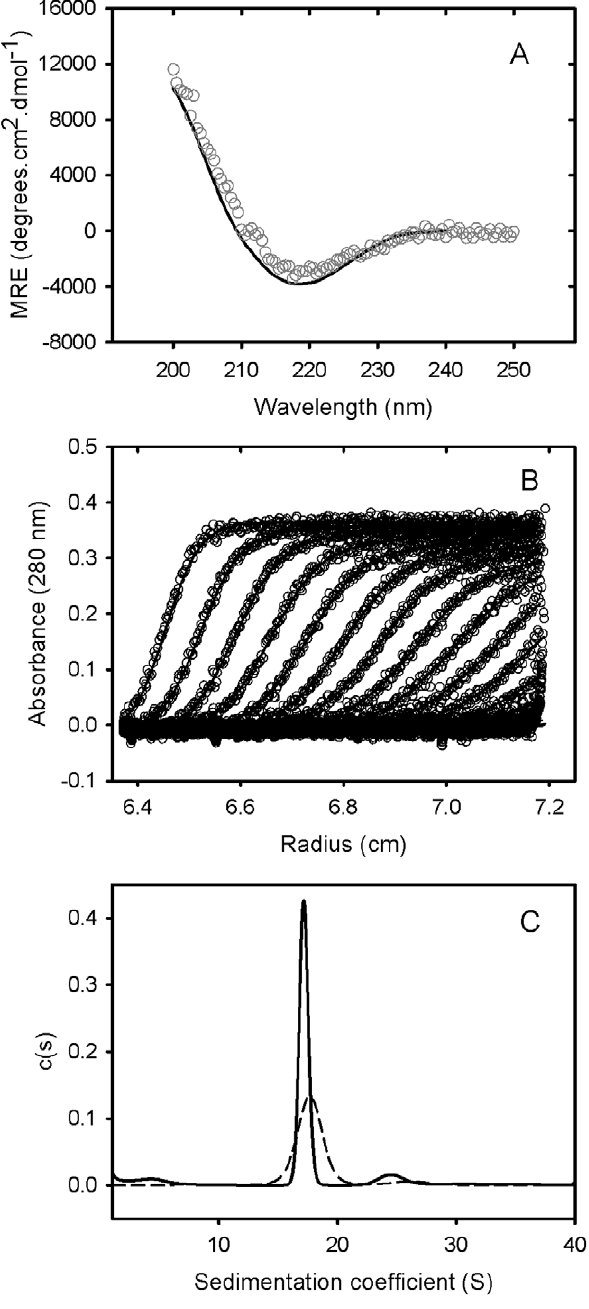
Figure 3. Solution characterisation of PAT-SM6. (A) 0.15 mg/mL of PAT-SM6 was subjected to circular dichroism spectroscopy. A representative spectrum at 25 u C (open circles) and the fit from Dichroweb using filter set sp175 (solid line) is shown. (B) Sedimentation velocity analysis of PAT-SM6 was performed by centrifuging 0.4 mg/mL of PAT-SM6 at 28,000 rpm in an analytical ultracentrifuge. The resulting sedimenting absorbance boundaries were monitored at 280 nm and representative data shown as open circles. Fits to the experimental data using a c(S) sedimentation model are shown as solid lines. For clarity, only every 3rd scan is shown. (C) Size distribution plots for pentameric PAT-SM6 (solid line) and hexameric PAT-SM6 (dashed line) calculated from fitting data represented in (B) to a c(S) sedimentation